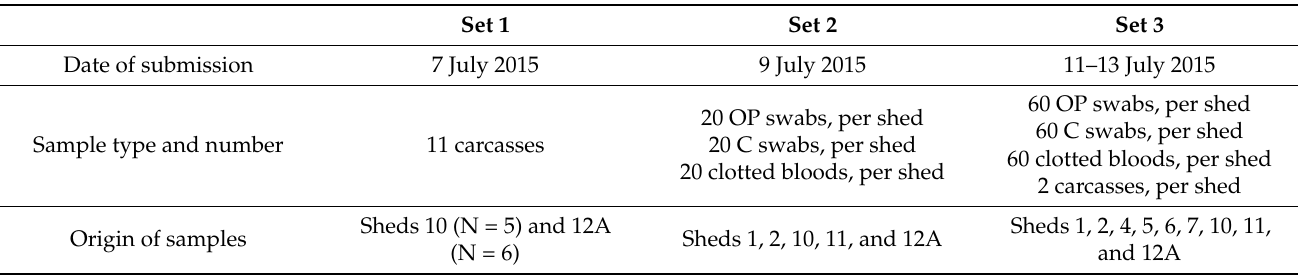
Table 1. Samples were collected from the infected premises (IP) in three separate sample sets. OP, oropharyngeal and C, cloacal. Set 1 Set 2 Set